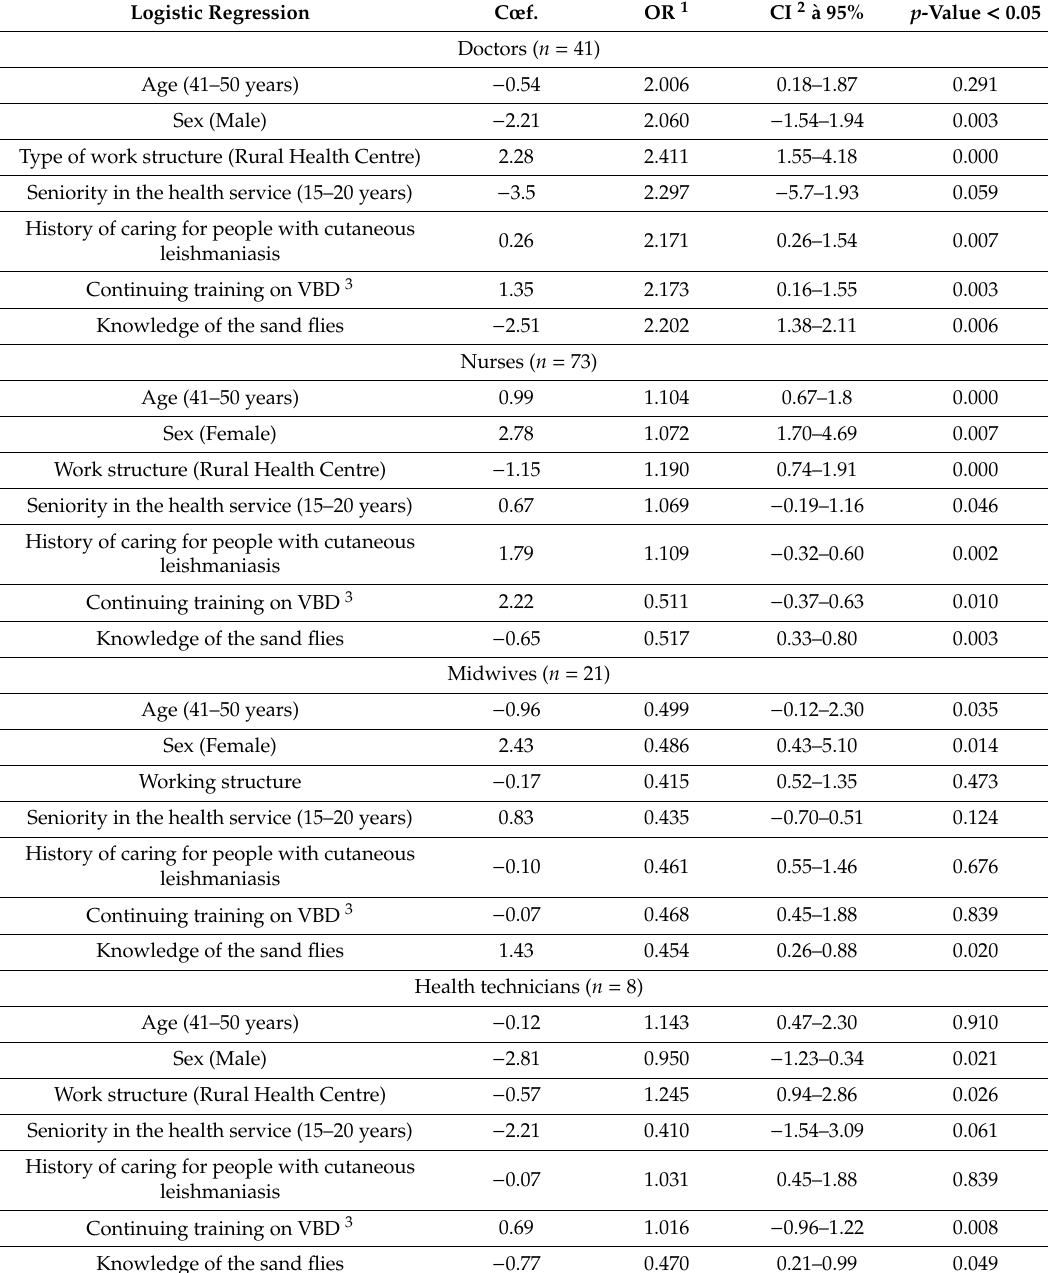
Table 3. Factors associated with high sand flies knowledge according to each occupational